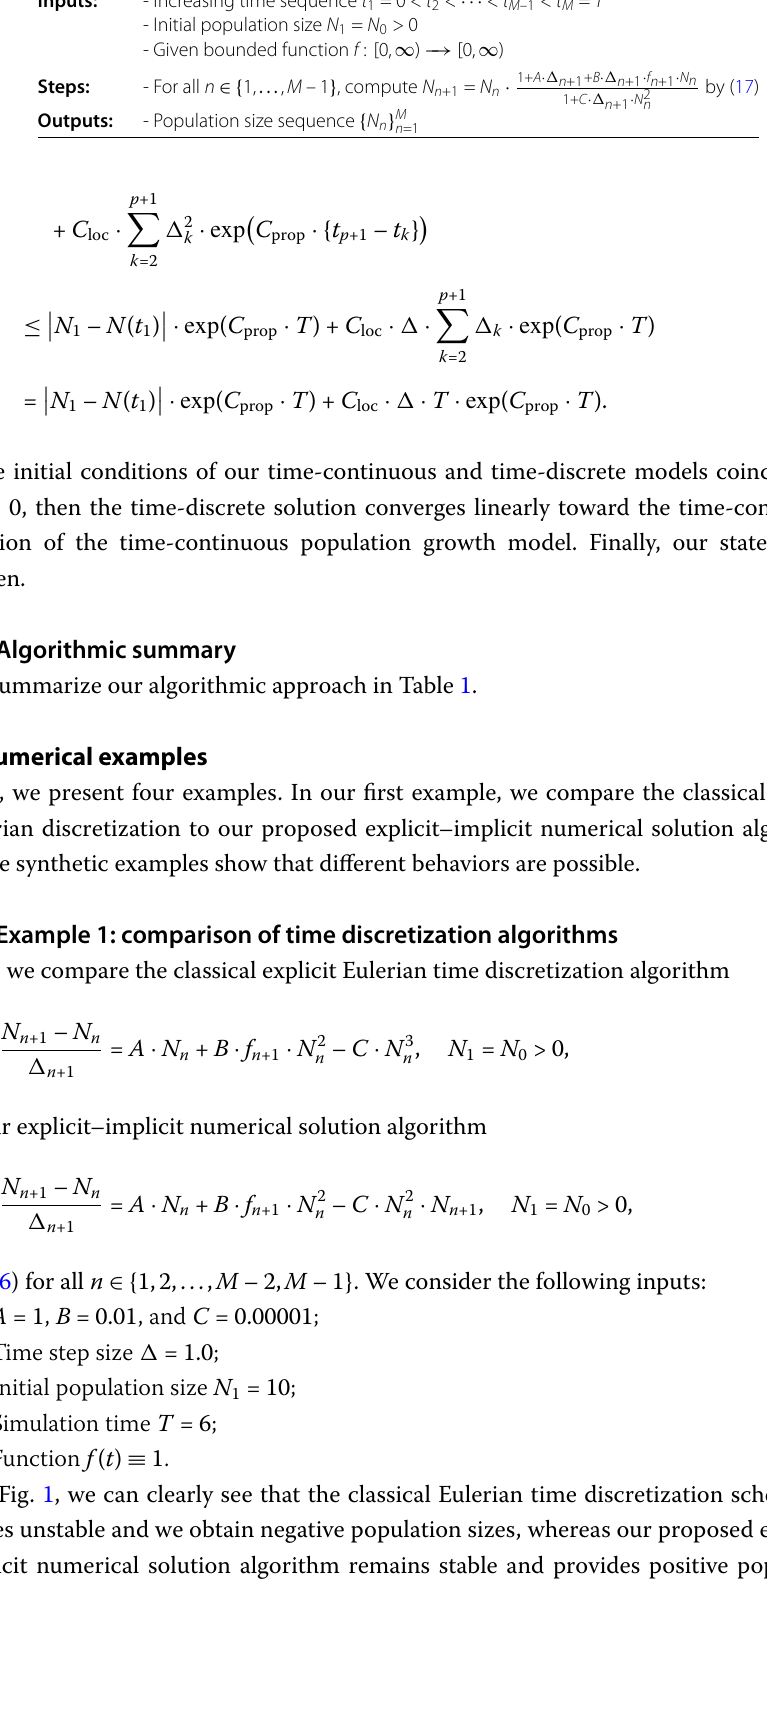
Table 1 Algorithmic summary of our explicit–implicit time-discretion population growth model